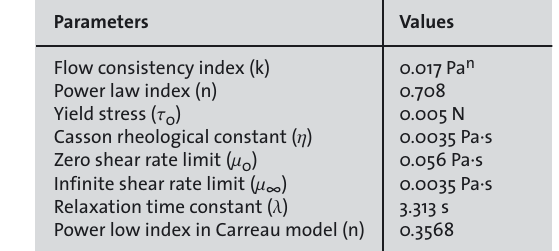
Table 1: Parametric values for the non-Newtonian constitutive